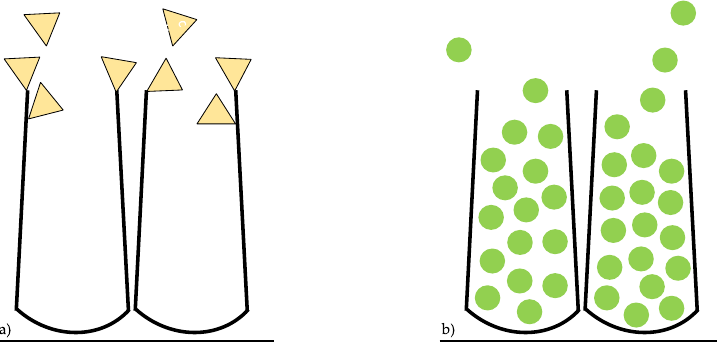
Figure 6. Various therapeutic and bioactivity enhancements performed on nanotubes. Adapted from Guo T et al., 2021. ( a ) illustrates how the reactive site on the surface may be used to graft different coatings (like nanoparticles or biopolymer); ( b ) illustrates how different substances may be incorporated into NT (as a growth factor, nanoparticles, anti-bacterial drugs) in order to ensure progressive delivery.